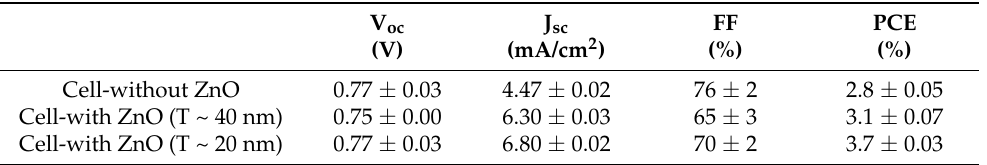
Table 2. Device parameters of cells without and with ZnO thin layer as electron transport layer